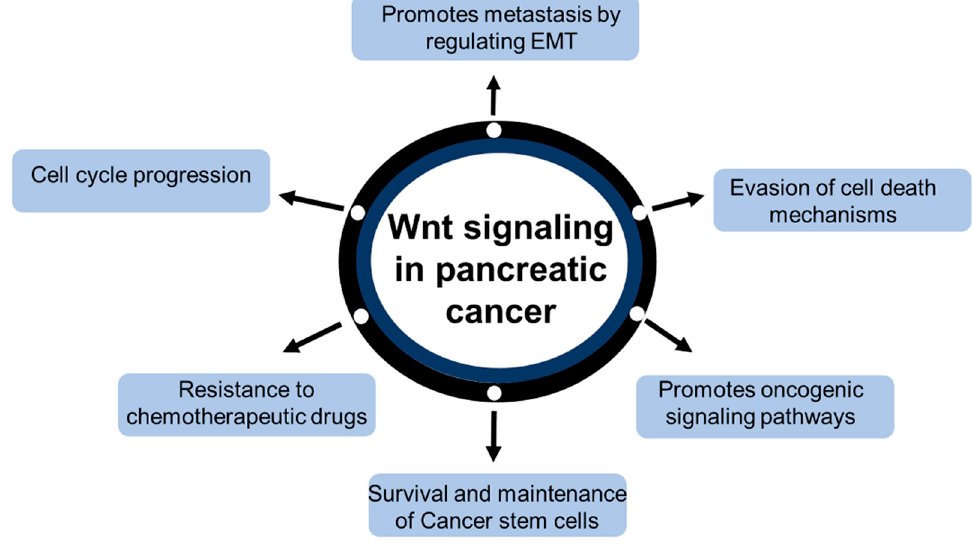
Figure 2. Oncogenic role of Wnt/ β -catenin signaling in pancreatic cancer.